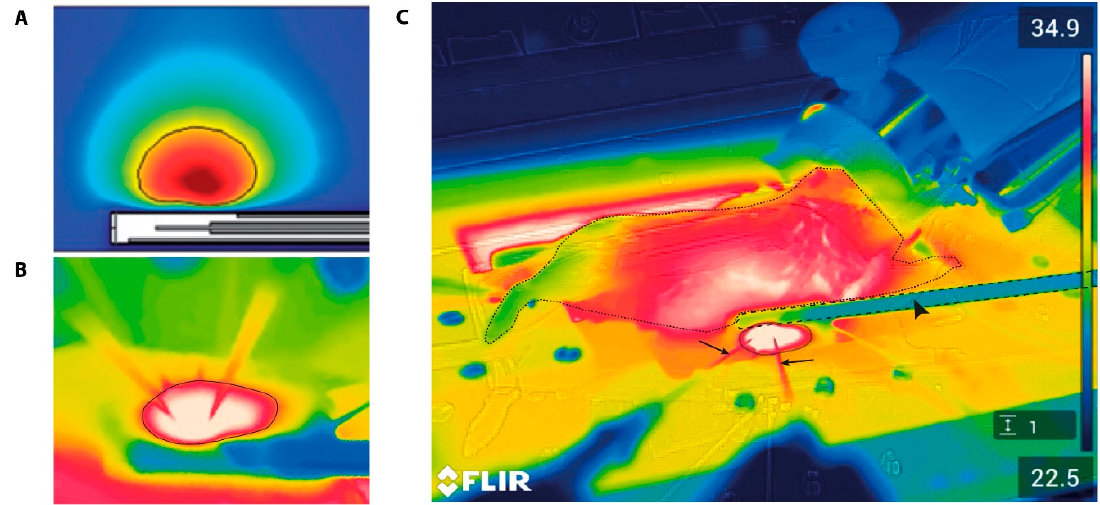
Figure 12. Simulated ( A ) and in vivo ( B , C ) temperature profiles of the DMA. ( A ) Simulated temperature profiles of the device indicate that the hot spot was directly in line with the monopole antenna. In addition, regions in direct contact with the applicator surface had a diminished temperature elevation in comparison to the more distant tumor regions; ( B ) in vivo temperature profiles are similar to the simulations from ( A ), indicating the lowest temperature in the water-cooled antenna (blue) and the highest temperature in the target area (white); ( C ) infrared image of the set-up overview: the animal is marked by the thin dashed line, the antenna is marked by a dashed line and indicated with a closed arrow head, the liver is marked with a solid line, and the arrows indicate the needle-tip thermocouples. Figure 12A is reproduced with permission from Curto et al. (2018) [29].